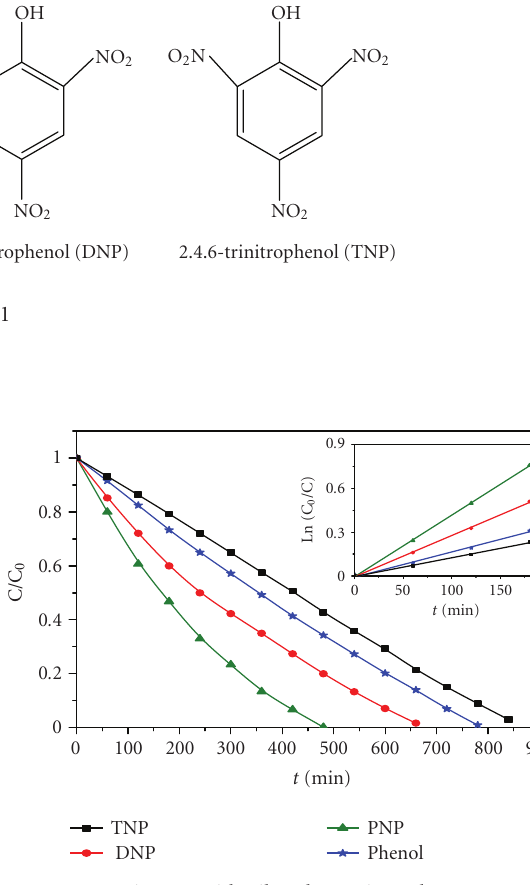
Figure 8: Experiments with pilot plant using solar energy, phenols disappearance. In the insert: first-order linear transforms Ln C 0 /C = f ( t ) of nitrophenols degradation. Experimental conditions: C 30 mg/L, V = 20L, TiO2 supported on Ahlstrom paper 1048, natural pH.